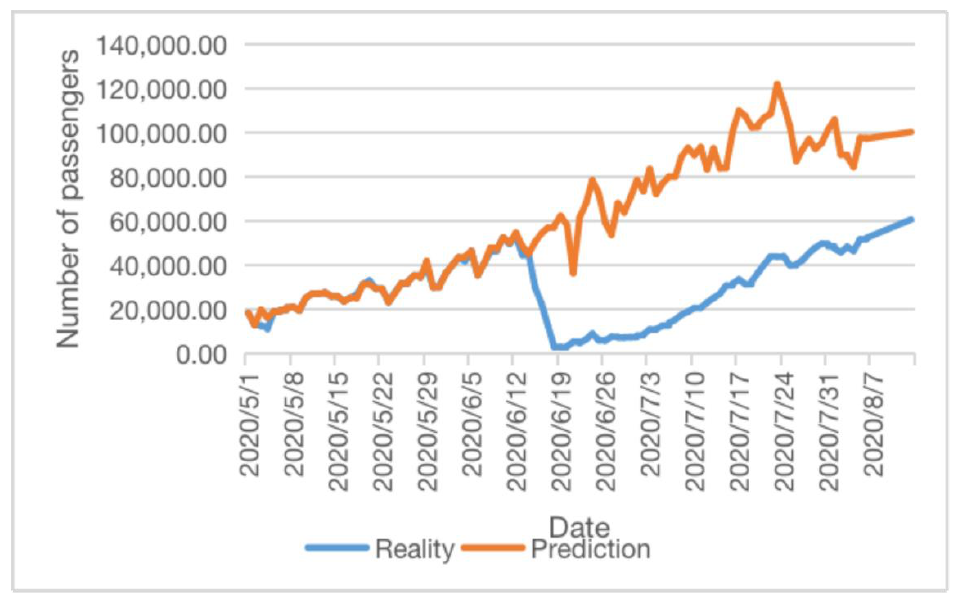
Figure 6. Beijing air passenger changing trend (LightGBM).